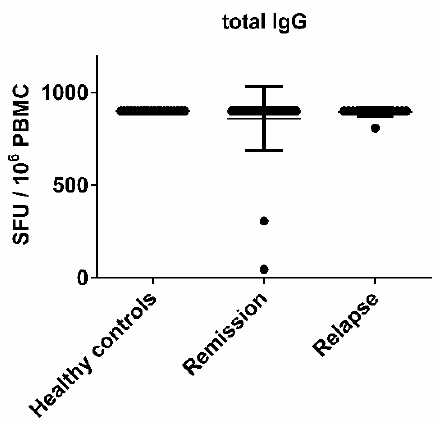
Figure 1. No significant difference in the numbers of immunoglobulin G (IgG)-secreting B cells between healthy controls and multiple sclerosis (MS) patients. Peripheral blood mononuclear cells (PBMC) were obtained from healthy controls, MS patients in remission and during an acute relapse. The numbers of total IgG secreting B cells in the polyclonally stimulated PBMC population are shown. Bars represent median values and standard deviations.